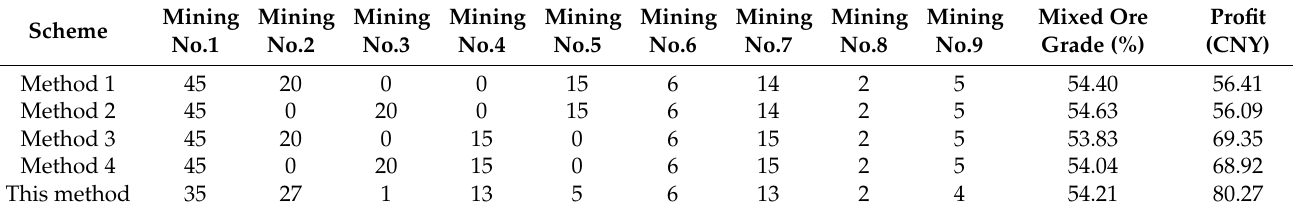
Table 12. Ore blending scheme in